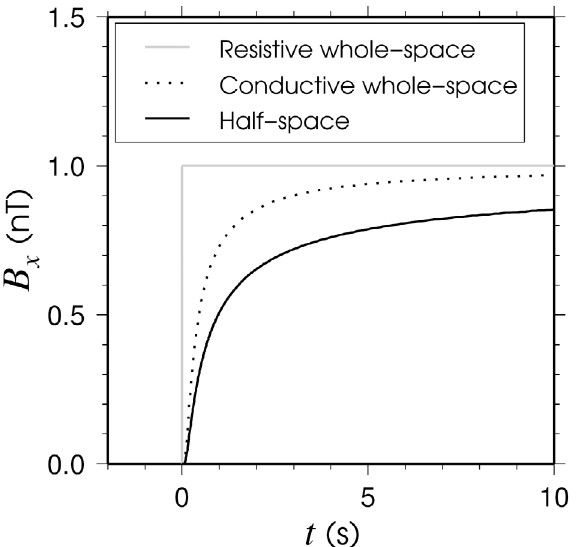
Figure 7. A comparison of the temporal variation in the vertical component of the magnetic field for the source-receiver geometry shown in Figure 4b for four conductivity values.